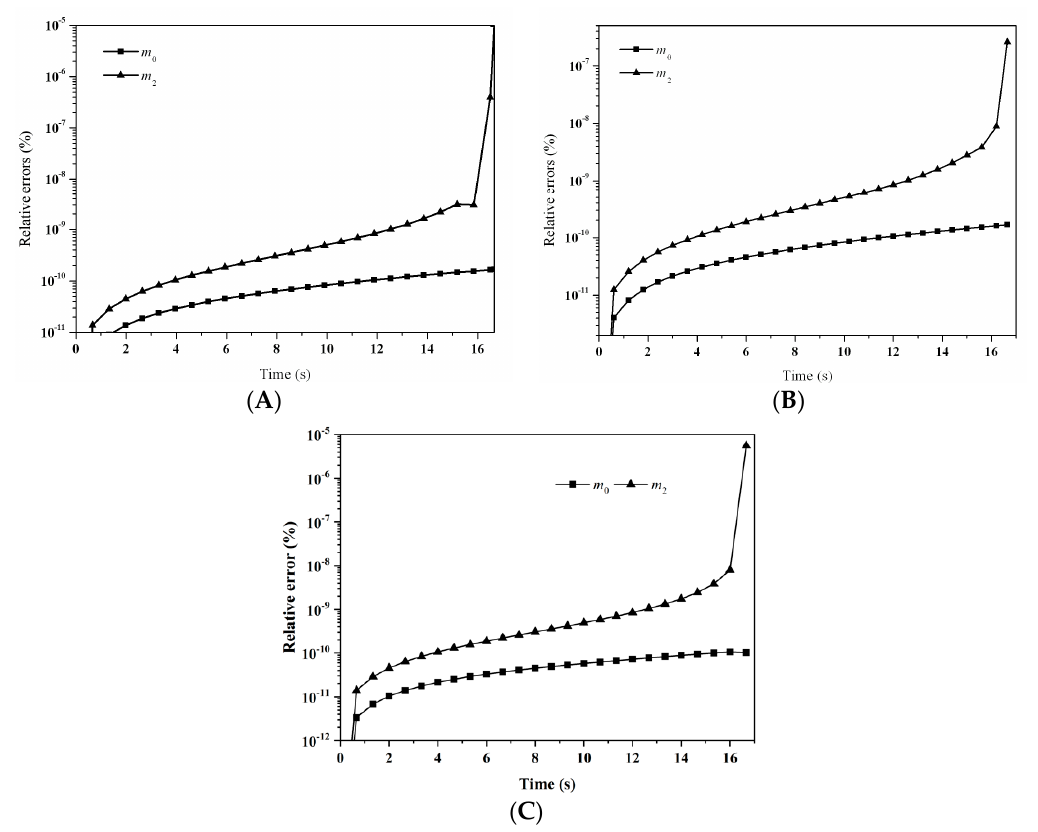
Figure 11. Relative errors for m 0 and m 2 for the pure aggregation process with product kernel and Gaussian initial PSD with: ( A ) LFPQMOM; ( B ) QMOM; and ( C ) FPQMOM (square: m 0 ; up triangle: m 2 ).